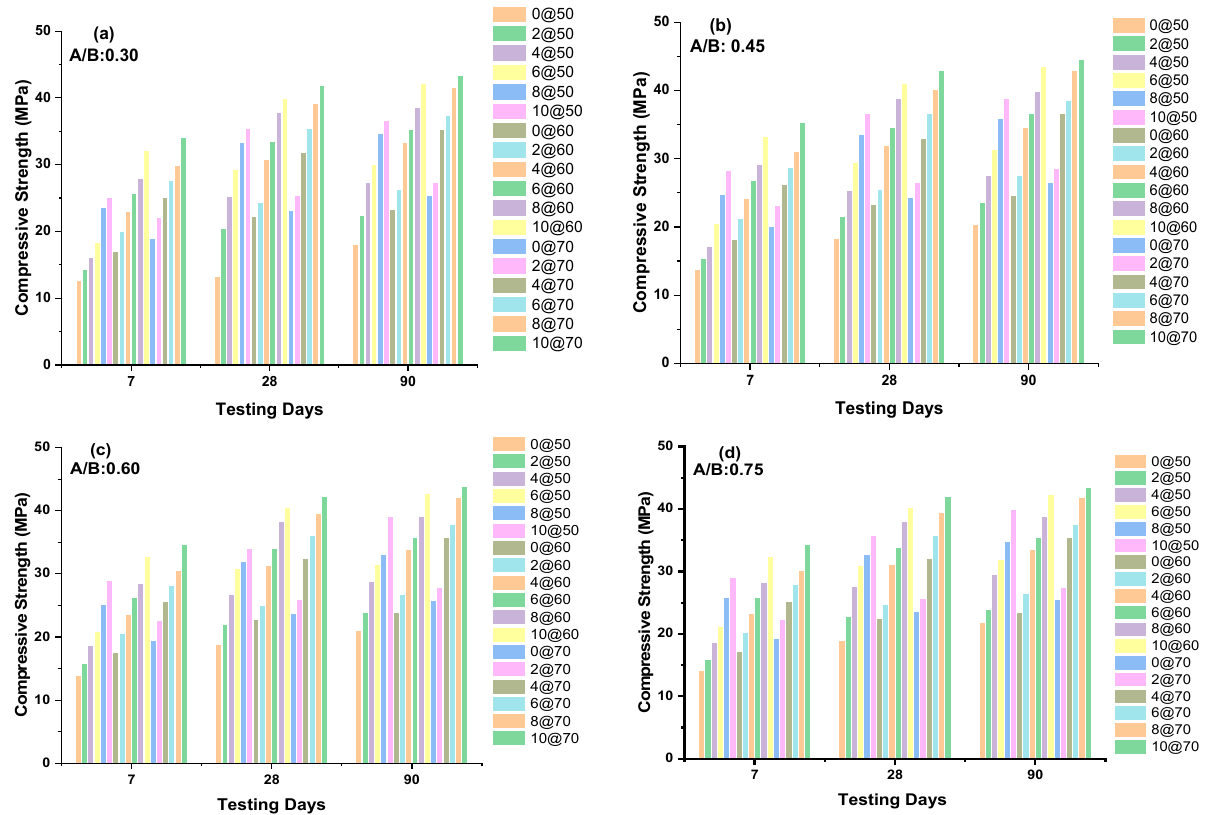
Figure 4. ( a – d ). The NDT test results for 7, 28, and 90 days of testing. ( a ) NDT tests at A/B: 0.30, ( b ) NDT tests at A/B: 0.45, ( c ) NDT tests at A/B: 0.60, ( d ) NDT tests at A/B: 0.75. For an A/B ratio of 0.45, 10 at 50 (for 10 h of duration, the specimens were exposed to a temperature of 50 ℃ ), this ratio was found to have % increment of CS values of 8%, 6.5%, 4.6%, and 3.2% compared with 0 at 50, 2 at 50, 4 at 50, and 6 at 50, respectively, at day 7. For an A/B ratio of 0.45, at day 28, 10 at 60 (for 10 h of duration, the specimens were exposed to a temperature of 60 ℃ ), this ratio was found to have increments of CS values of 9%, 7.5%, 5.9%, and 3.8% compared with 0 at 60, 2 at 60, 4 at 60, and 6 at 60, respectively. For an A/B ratio of 0.45, at day 90, 10@70 (for 10 h of duration, the specimens were exposed to a temperature of 70 ℃ ), this ratio (for 10 h at a temperature of 70 ℃ , exposed to GPC) was found to have increments of CS values of 6%, 4.3%, 3.1%, and 1.9% compared with 0 at 70, 2 at 70, 4 at 70, and 6 at 70, respectively.